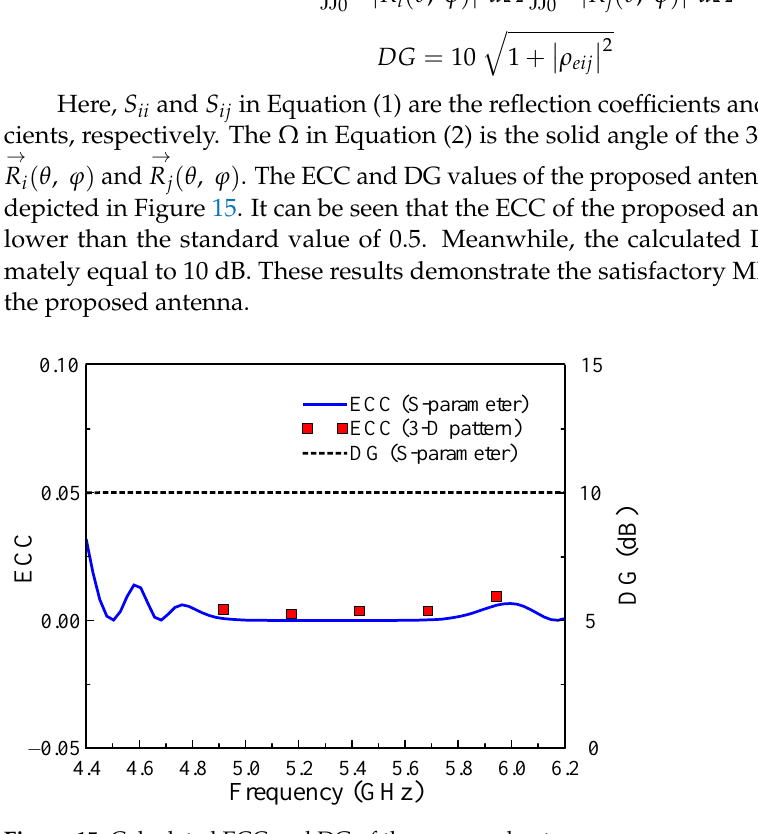
Figure 15. Calculated ECC and DG of the proposed antenna.